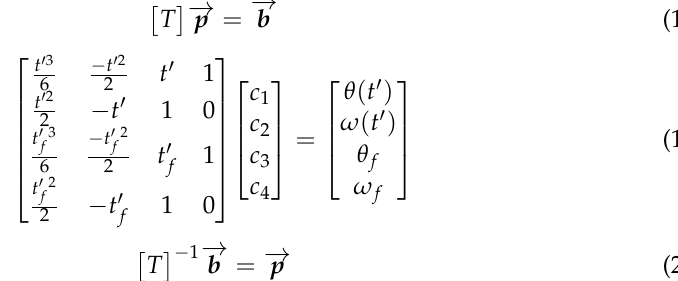
Table 2. Figures of Merit for RTOC implementing various MATLAB inversion techniques while adding uncertainty. Gaussian noise in ˆ θ and ˆ ω of σ = 0.01 and Uniform Distribution of I = 1 ± 0.1